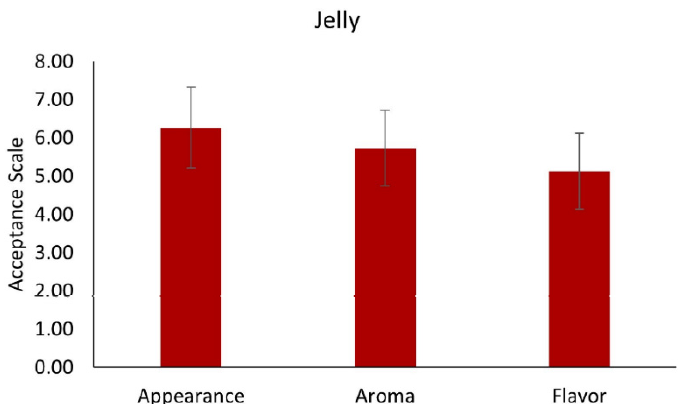
Figure 6. Sensory evaluation of jelly with added muicle extract MD microcapsules. 1 = Dislike Very Much, 2 = Dislike Moderately, 3 = Dislike Slightly, 4 = neither like nor dislike, 5 = Like Slightly, 6 = Like Moderately, 7 = Like Very Much.